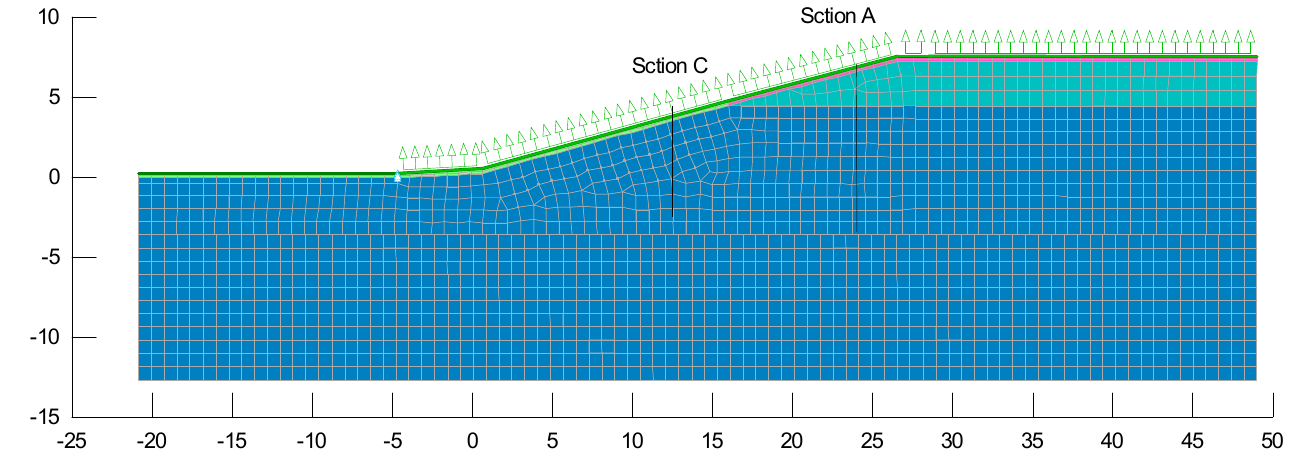
Figure A4. Geometry and mesh used for sensitivity analysis GM2.